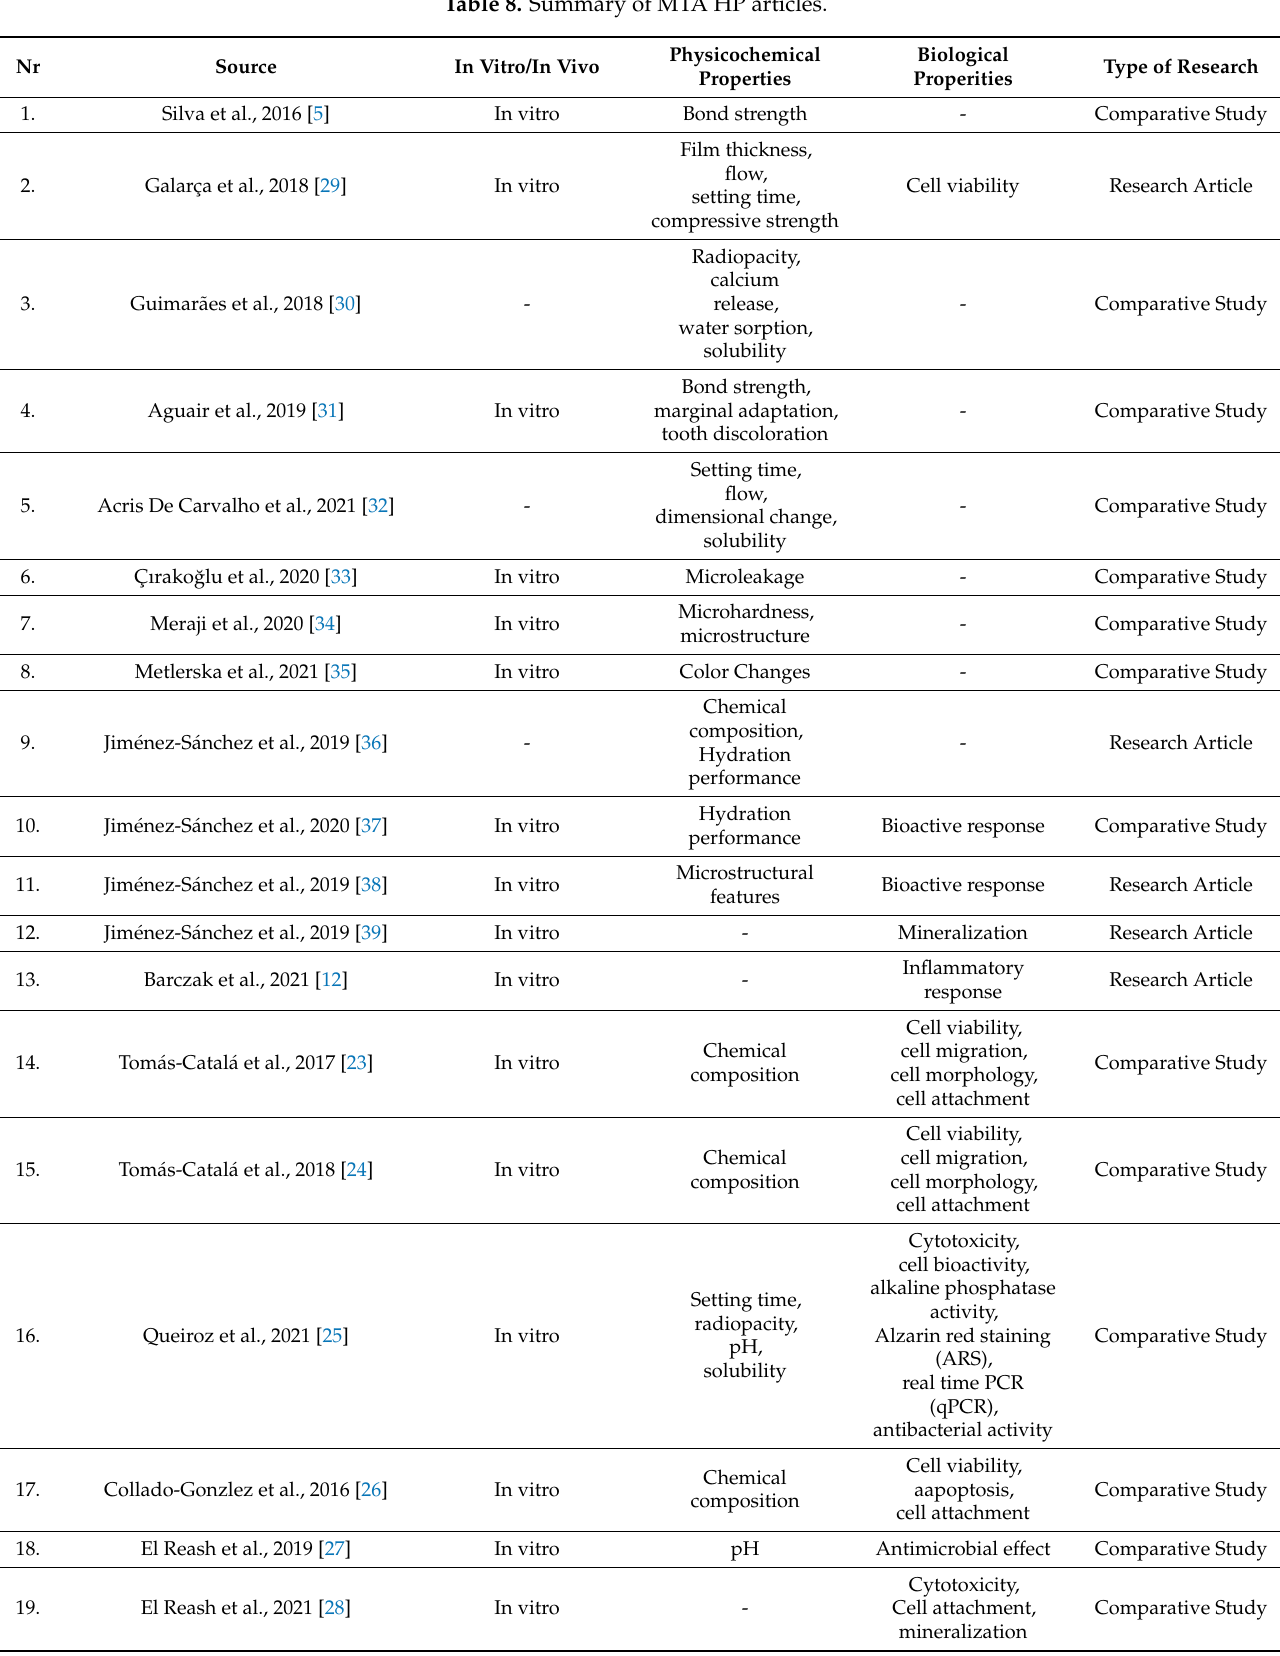
Table 8. Summary of MTA HP